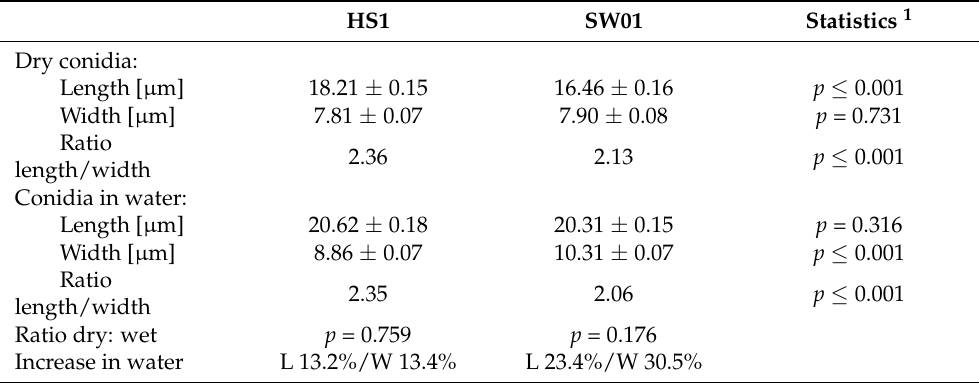
Table 1. Morphology of dry and hydrated conidia of Venturia inaequalis isolates HS1 (wild type) and SW01 (melanin-deficient). Mean ± standard error of the mean (n = 200). HS1 SW01